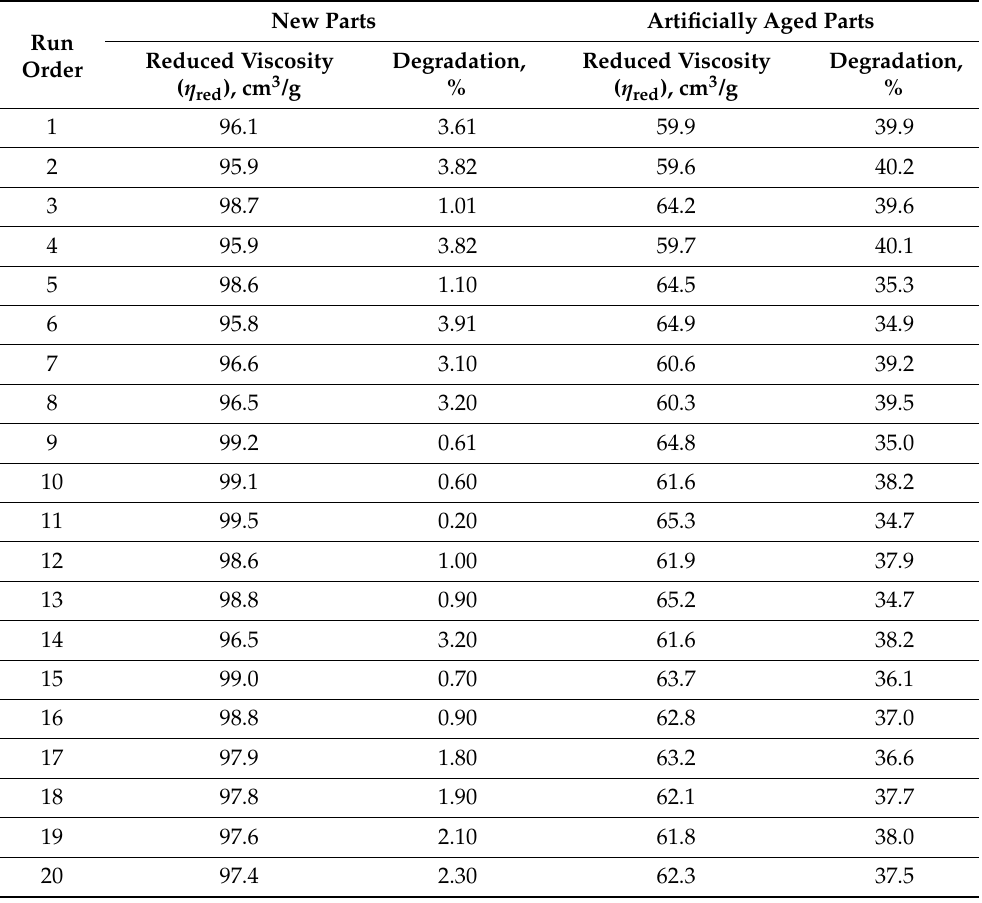
Table 10. Reduced viscosity ( η red ) values for new and artificially aged parts. New Parts Artificially Aged Parts Run Reduced Viscosity Order ( η red ), cm 3 /g